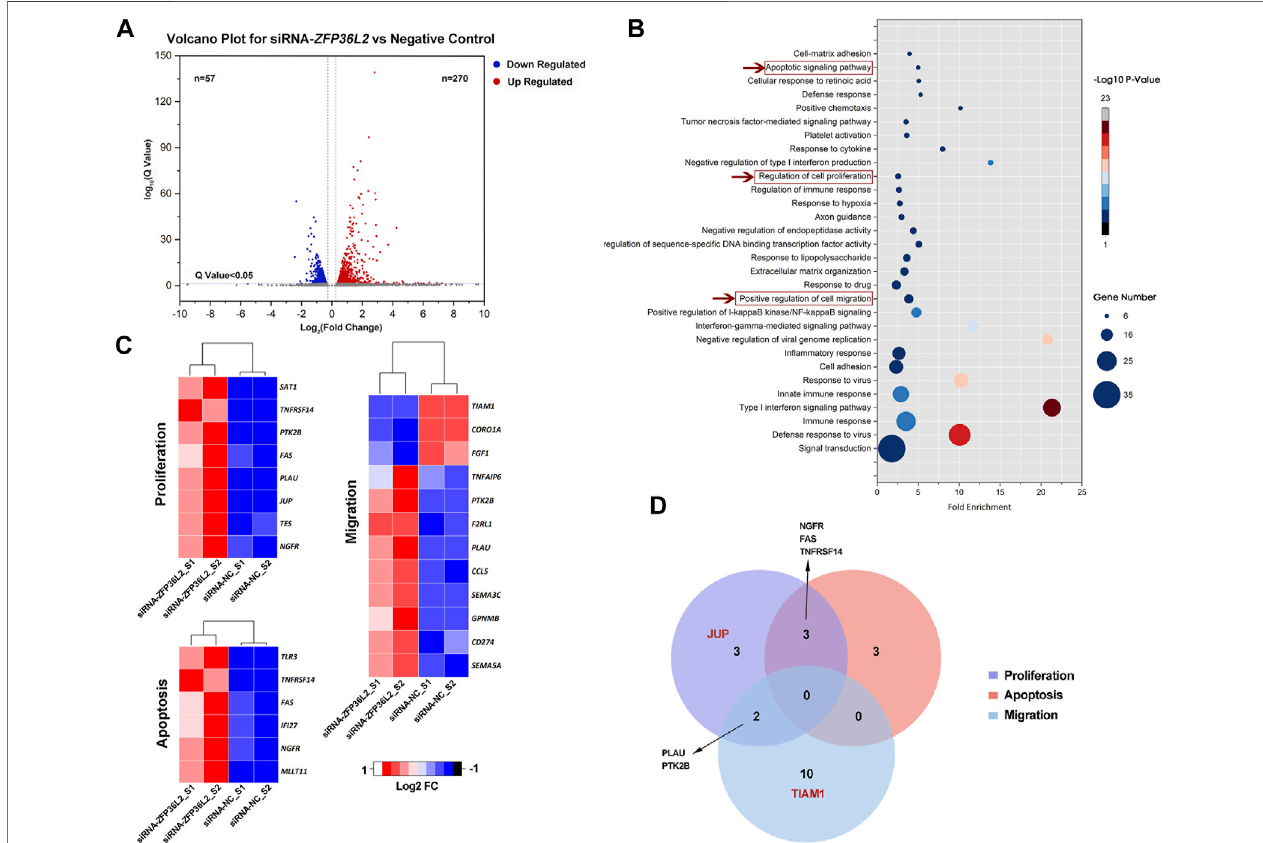
FIGURE 2 | (A) Volcano plot for differential gene expression. (B) GO biological process terms enriched in DEGs. A total of 67 GO terms were signi fi cantly enriched ( p < .05), the fi gure shows the top 30 GO terms with the most genes. (C) Fold change (Log2 FC) of genes among “ Apoptotic signaling pathway, ” “ regulation of cell proliferation ” and “ positive regulation of cell migration ” biological processes. (D) Venn diagram showing number of genes associated with the terms “ apoptotic signaling pathway, ” “ regulation of cell proliferation ” and “ positive regulation of cell migration. ” The red font is indicative of genes where the SNPs associated with NSCLO or NSCPO were